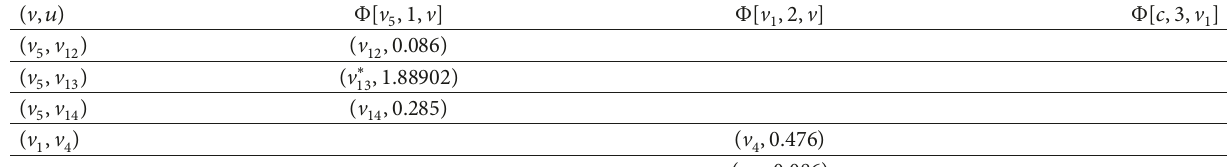
Table 1: Calculating the table entries Φ[𝑐, 3, V 1 ] , Φ[𝑐,3, V 2 ] , and Φ[𝑐, 3, V 3 ]